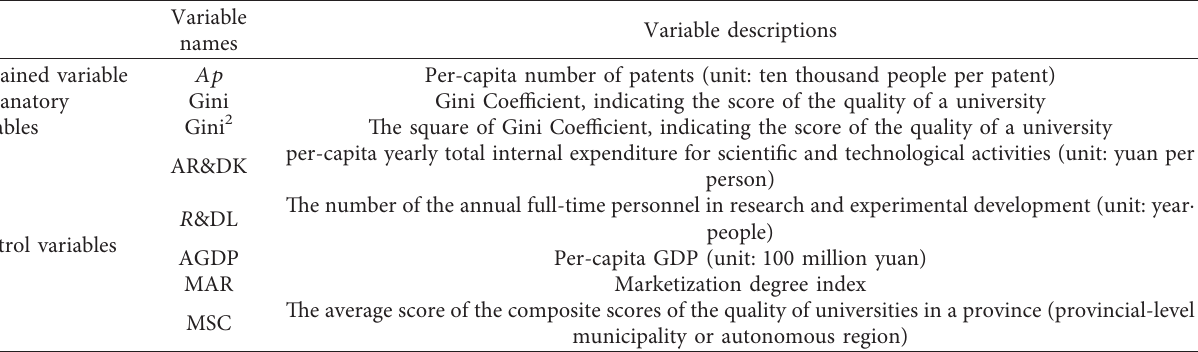
Table 2: Selection and description of regional